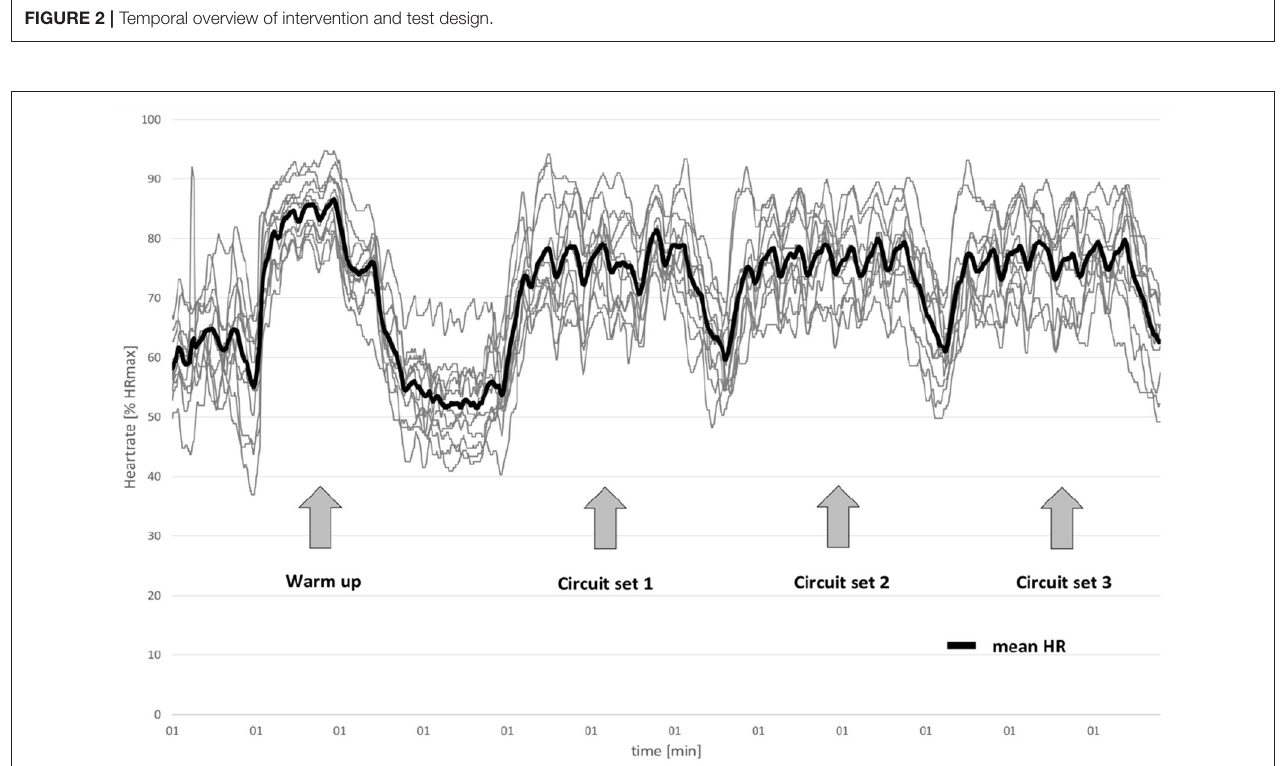
FIGURE 3 | Example of mean (thick line) and single heart rates (thin lines) in one training session ( n = 11).